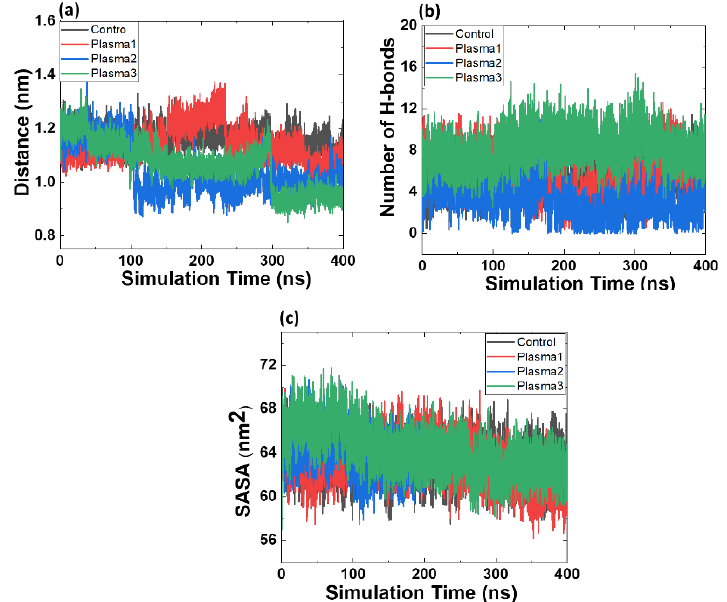
Figure 8. ( a ) Minimum distance formed between Mdm2 and p53 protein in the native and oxidized state, ( b ) total number of hydrogen bonds formed between Mdm2 and p53 protein in the native and oxidized state, and ( c ) solvent-accessible surface area (SASA) of Mdm2–p53 complex.